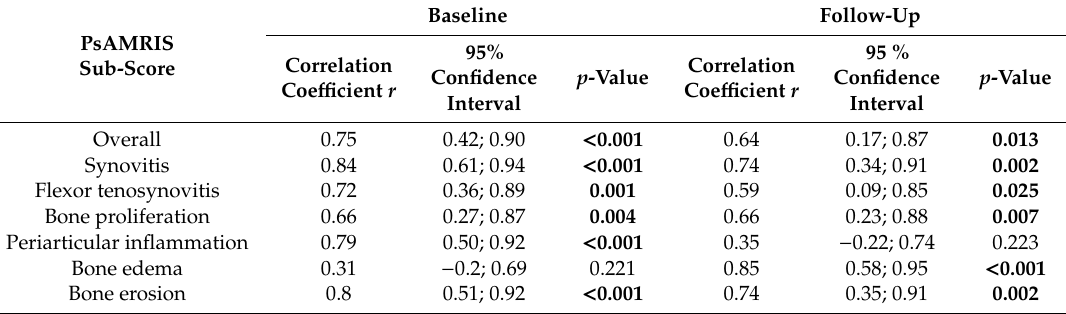
Table 5. Pearson’s correlation coefficients r of PsAMRIS and sPsAMRIS for the overall score as well as each sub-score at baseline and follow-up. p -values of p < 0.05 were considered significant and are given in bold type.